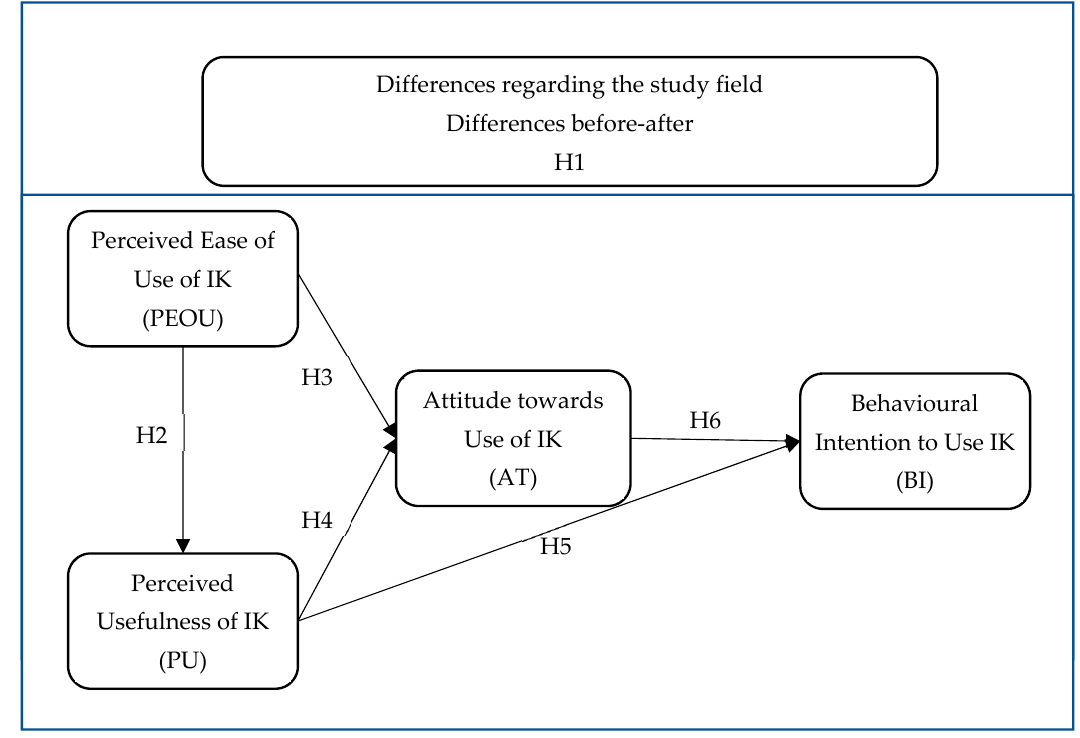
Figure 5. Conceptual model of research.